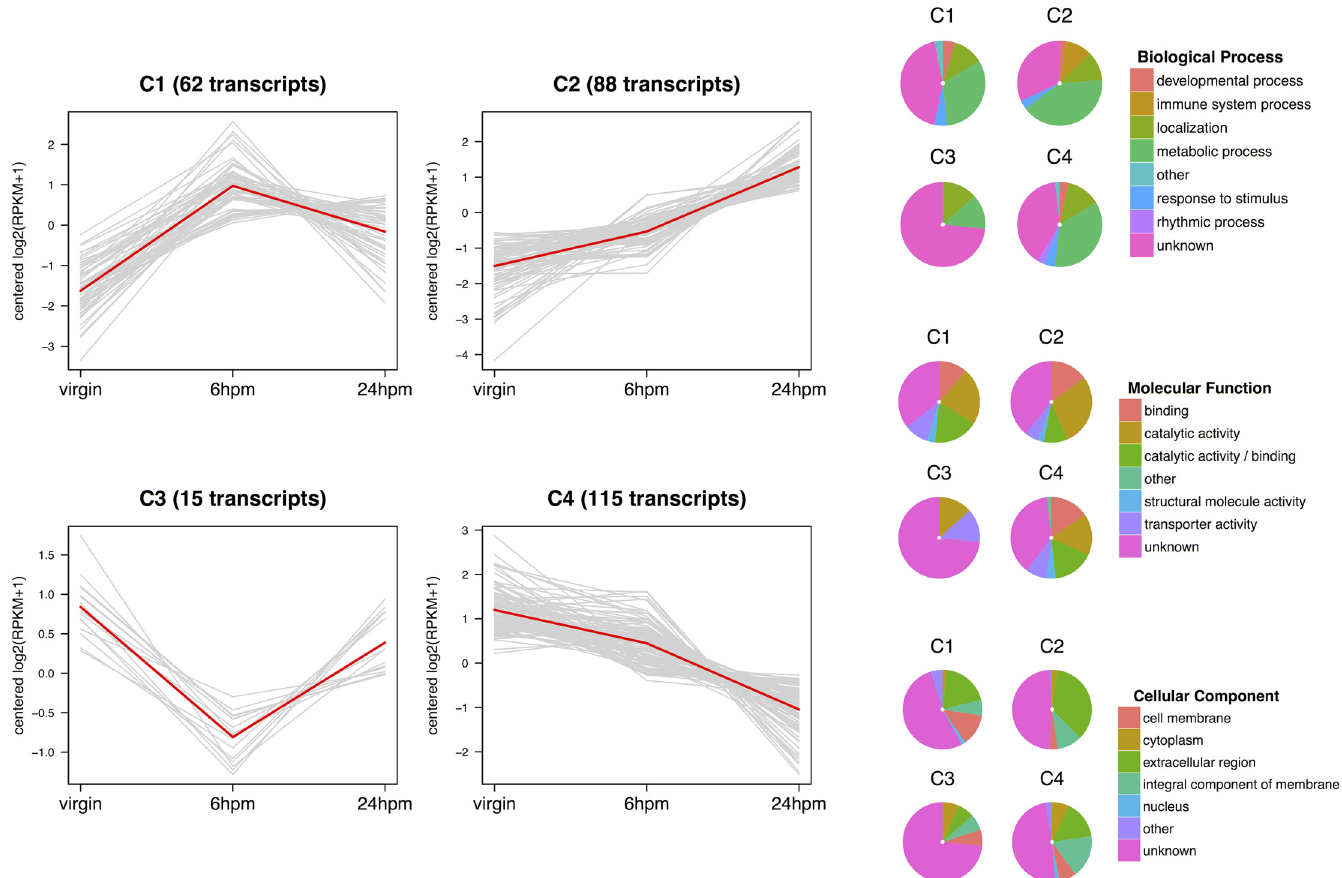
Fig 5. Transcripts that are significantly up- or down-regulated at 6 and 24hpm. (A) Merged clusters from the K -means clustering analysis depicting the four mean expression profiles (red line) among transcripts differentially expressed between virgin and later time-points (6hpm and 24hpm). (B) Pie charts of GO terms associated with up-regulated transcripts (C1 and C2) and down-regulated transcripts (C3 and C4). Only ancestral GO terms are shown for the three ontology